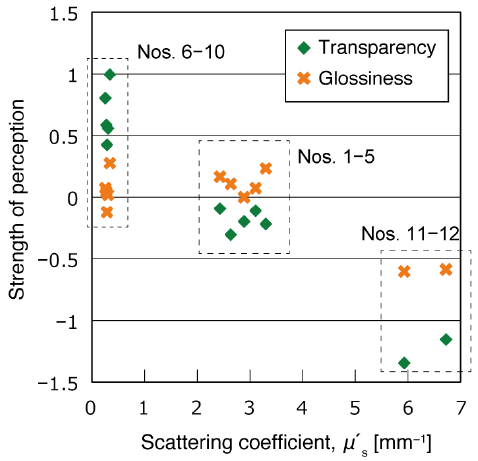
Figure 9. Results of sensory test for translucency and glossiness as a function of the scattering coefficient of the sample.